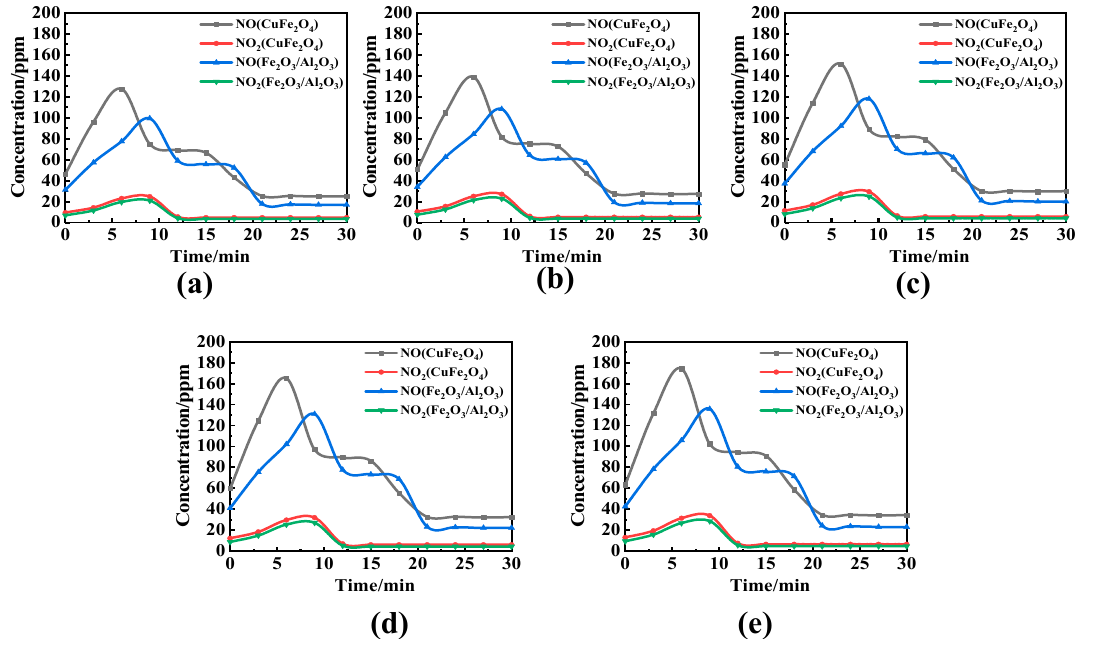
Figure 7. The variation trend of NO and NO 2 with time in the process of CLC at ( a ) 650 °C, ( b ) 700 °C, ( c ) 750 °C, ( d ) 800 °C and ( e ) 850 °C.